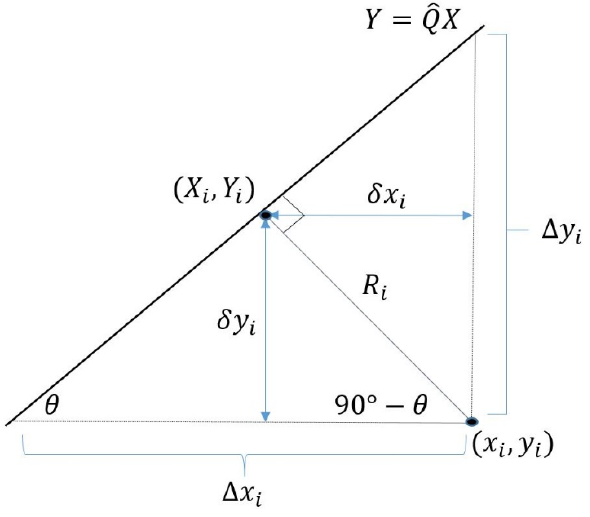
Figure 3. Geometry method.